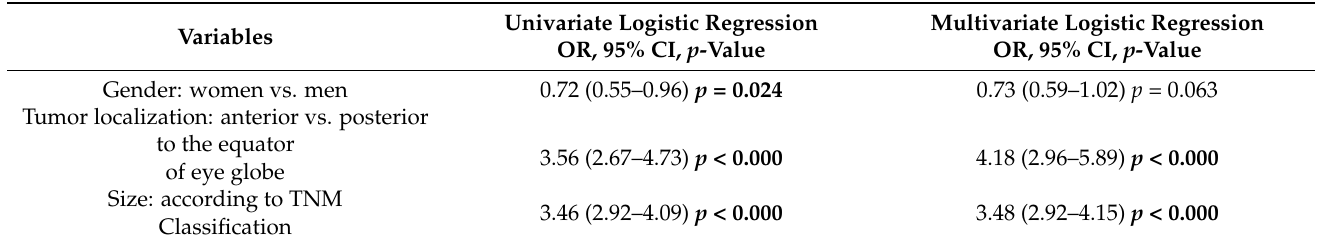
Table 5. Univariate and multivariate logistic regression models for risk factors associated with medical management of uveal melanoma (globe-sparing therapies vs. enucleation).